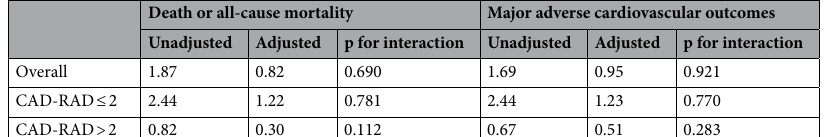
Death or all-cause mortality Major adverse cardiovascular